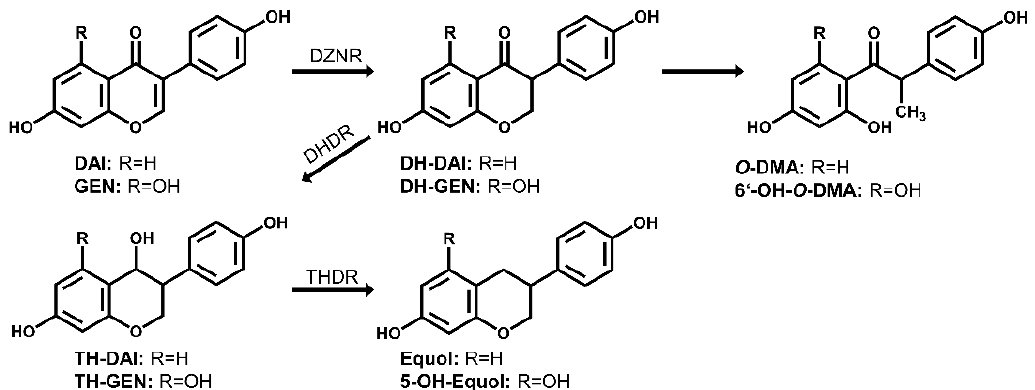
Figure 1. Metabolism of daidzein and genistein by human gut bacteria. Modified based on [6,7]. Daidzein (DAI); genistein (GEN); dihydrodaidzein (DH-DAI); dihydrogenistein (DH-GEN), tetrahydrodaidzein (TH-DAI); tetrahydrogenistein (TH-GEN); 5-hydroxyl-equol (5-OH-equol); O -desmethylangolensin ( O -DMA); 6 ′ -hydroxy- O -desmethylangolensin (6 ′ -OH- O -DMA); daidzein reductase (DZNR), dihydrodaidzein reductase (DHDR); tetrahydrodaidzein reductase (THDR).